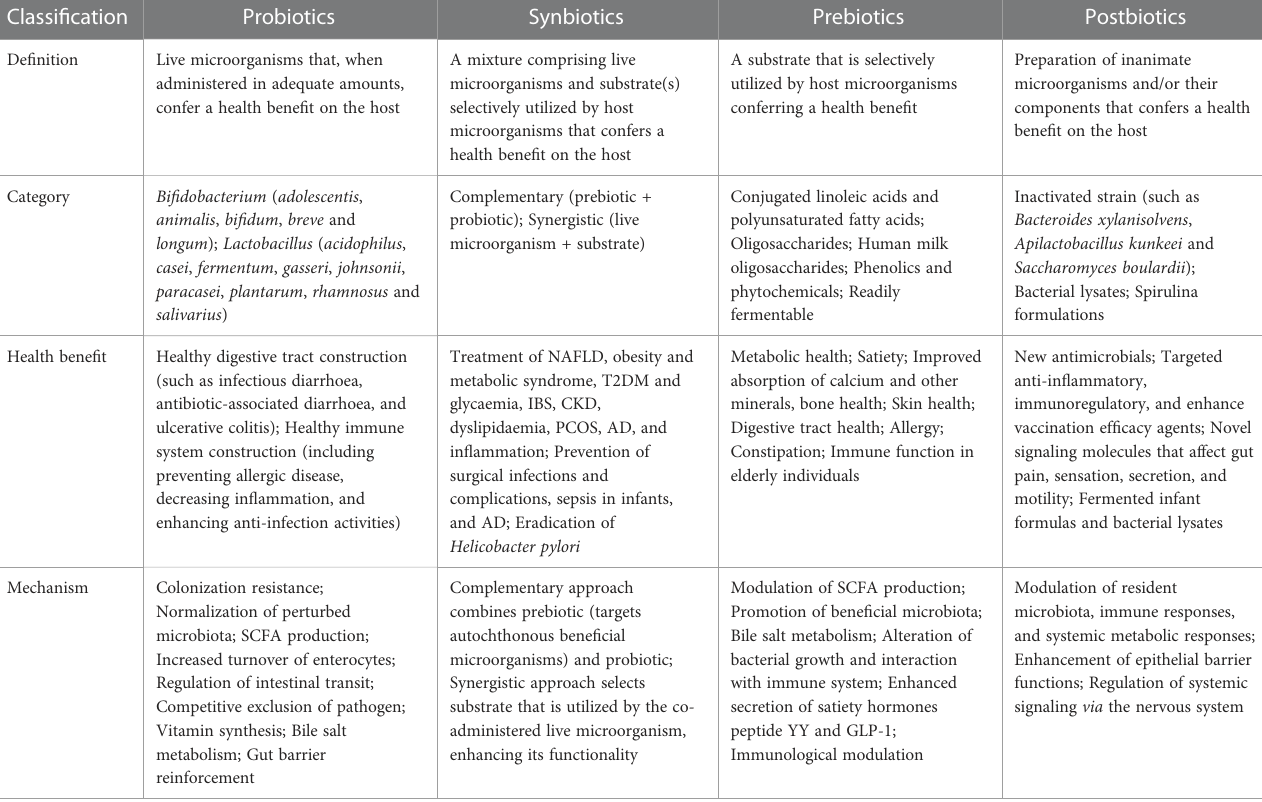
TABLE 1 Differences between probiotics, synbiotics, prebiotics, and